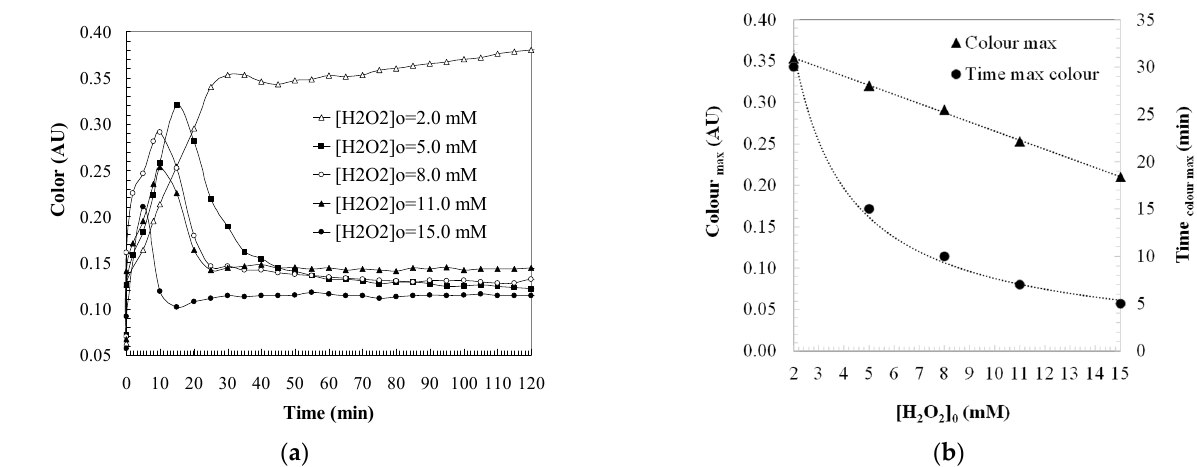
Figure 4. ( a ) Effect of hydrogen peroxide on colour changes in a photo-Fenton system during the carbamazepine oxidation. ( b ) Maximum colour formation (Colour max , AU) and time corresponding to the maximum colour formation (Time colour max , min) as a function of the oxidant dosage. Experimental conditions: [CBZ] 0 = 50.0 mg/L; pH = 3.0; [Fe] 0 = 10.0 mg/L; [UV] = 150 W; T = 40 °C